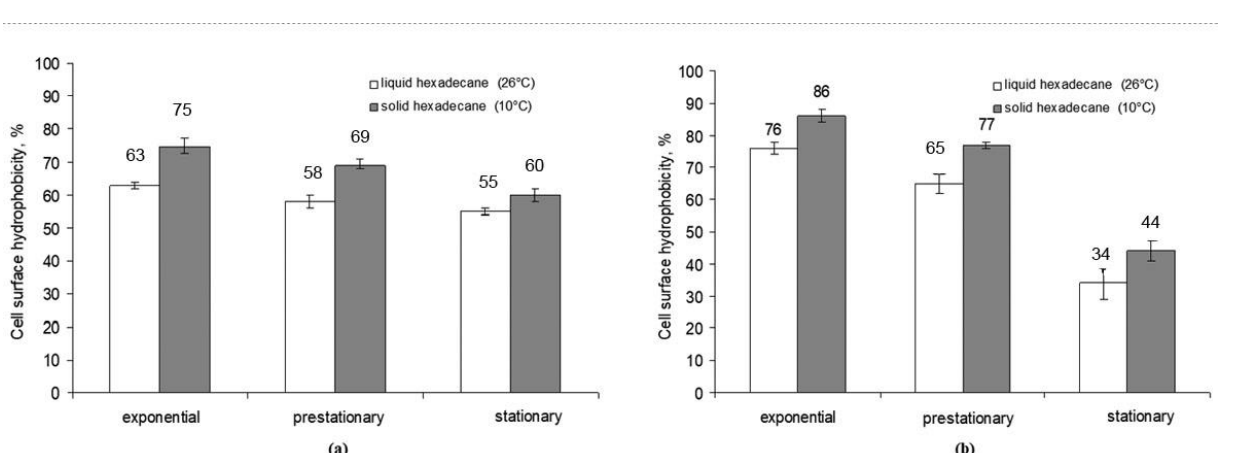
Table 1. Content of lipids, fatty acids and hexadecane in bacterial biomass (mg g − 1 ). Lipid Components, mg g −1